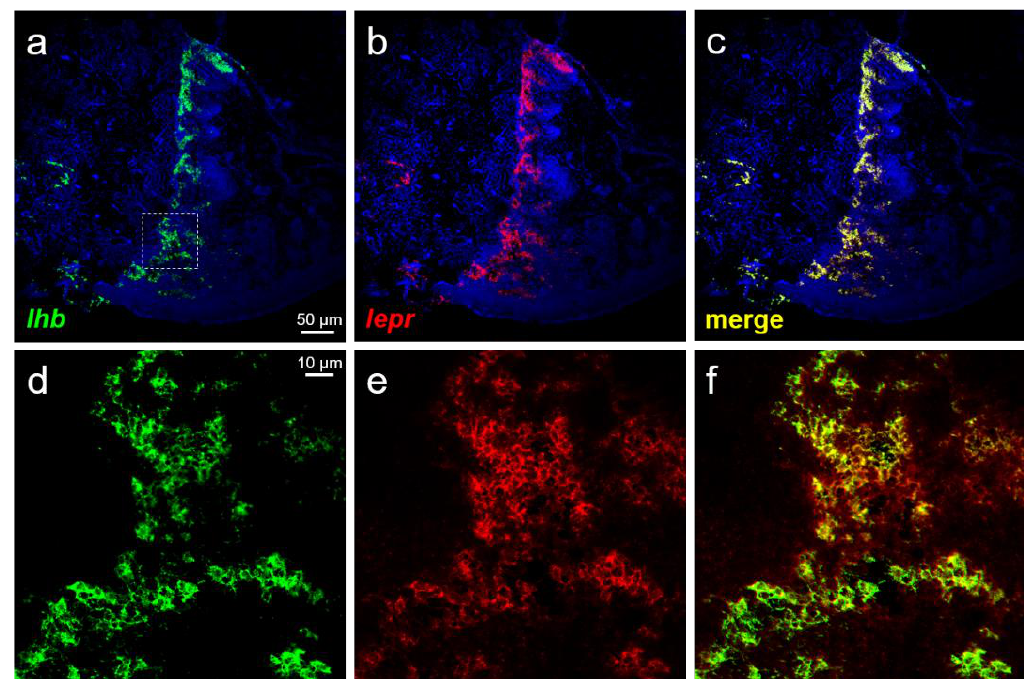
Figure 7. Double-label ISH in the pituitary of females. ( a ) Green fluorescence indicates the lhb mRNA-expressing cells. ( b ) Red fluorescence indicates the lepr mRNA-expressing cells. ( c ) Merged image of ( a ) and ( b ). ( d – f ) Magnified images of LH-producing cells (the area surrounded by a square in panel a ) showed that LH-producing cells co-expressed lepr mRNA. ( a – c ) : scale bars = 50 μm; ( d – f ) : scale bars = 10 μm.